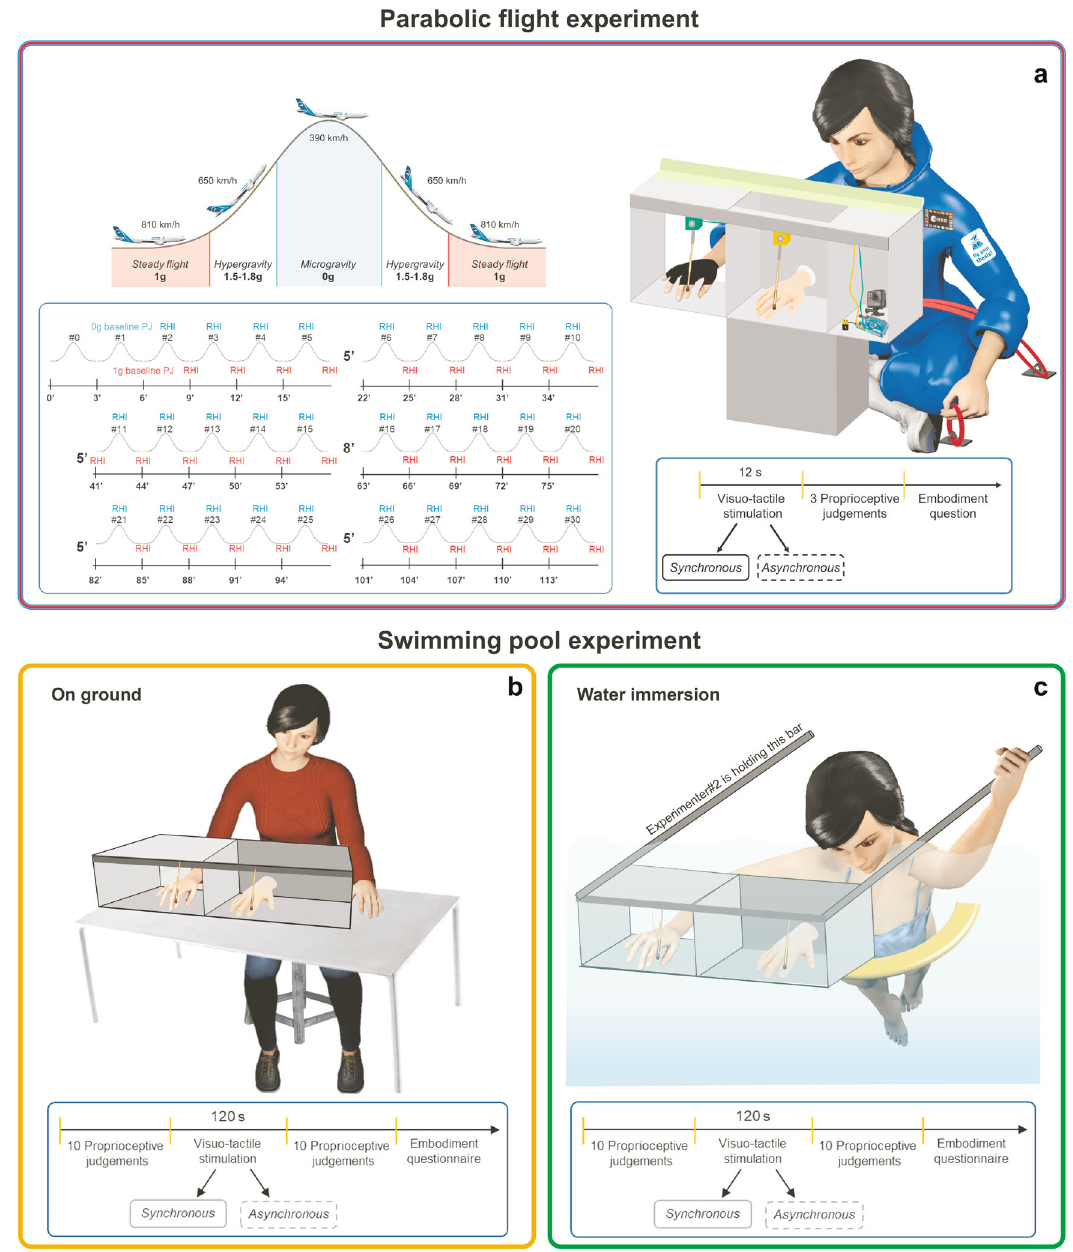
Fig. 1 Experimental settings. Upper panel ( a ): Parabolic fl ight experiment. Participants underwent the RHI procedure during a parabolic fl ight: in normal gravity (1 g, in red) during steady horizontal fl ight, and in microgravity (0 g, in blue). The tactile stimulation was delivered via a fully automated system assembled ad hoc for the experiment. Lower panel ( b , c ): Swimming pool experiment. Participants underwent the RHI both in an ordinary laboratory (on ground condition, in orange, b ) and in a private swimming pool (water immersion condition, in green, c ). For graphical purposes, the coat used to cover the right shoulder and arm of participants in both experiments is not shown in the fi